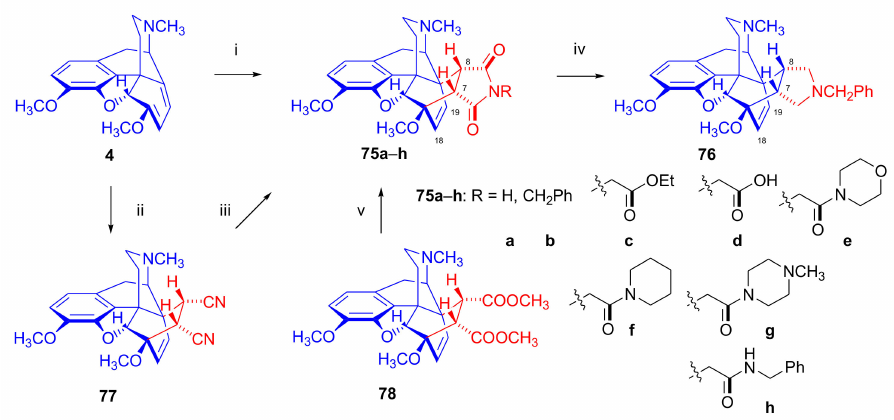
Figure 24. Thebaine-maleimide and N 1 -substituted maleimide adducts. Reagents and conditions : (i): R = H, maleimide, DMF, reflux, 15 h, 76% or maleamide, methanol, reflux, 72 h, 86%; R = CH 2 Ph, N -benzylmaleimide, ethanol, reflux, 1 h, quant.; (ii): maleonitril, toluene, reflux, 8 h, 80%;